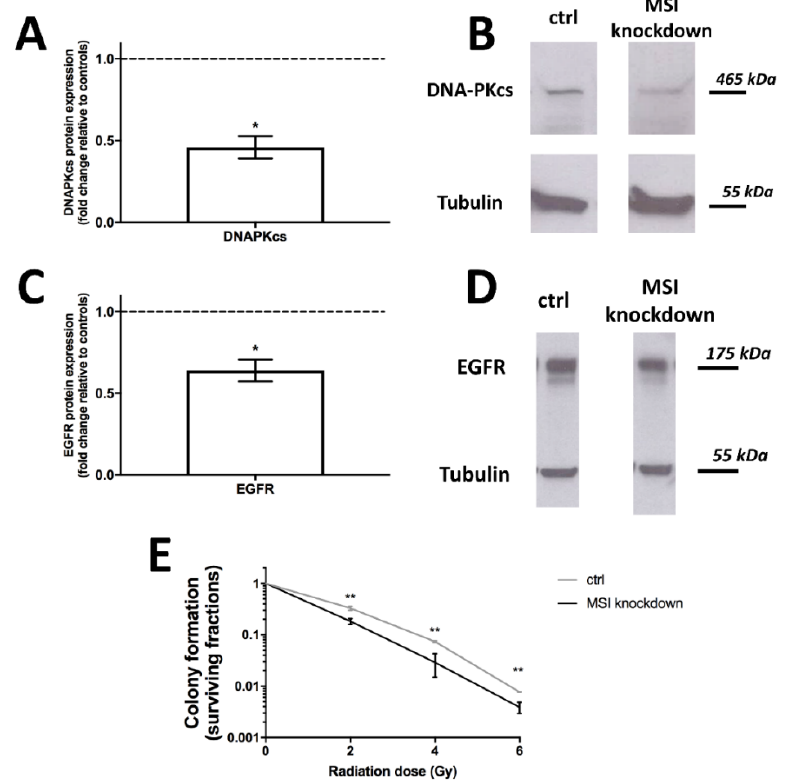
Figure 4. Influence of Musashi ( MSI ) RNA-binding protein knockdown on DNA protein kinase catalytic subunit (DNA-PKcs) and Epithelial growth factor receptor (EGFR) protein expression as well as radioresistance in triple-negative MDA-MB-231 cells. A : DNA-PKcs expression, as quantified by Western blot, is strongly downregulated after MSI knockdown, with representative blots in ( B ). C : EGFR expression, as quantified by Western blot, is downregulated after MSI silencing, with representative blots in ( D ). E : Radioresistance, as quantified by colony formation, is decreased after MSI knockdown and radiation doses of 2, 4 and 6 Gy, respectively, when compared to controls (ctrl). Cells were transfected with a control siRNA and MSI-1 and MSI-2 siRNA, respectively, as detailed in the Methods section (at least n = 3, * p < 0.05, ** p < 0.01, error bars indicate s.e.m.).